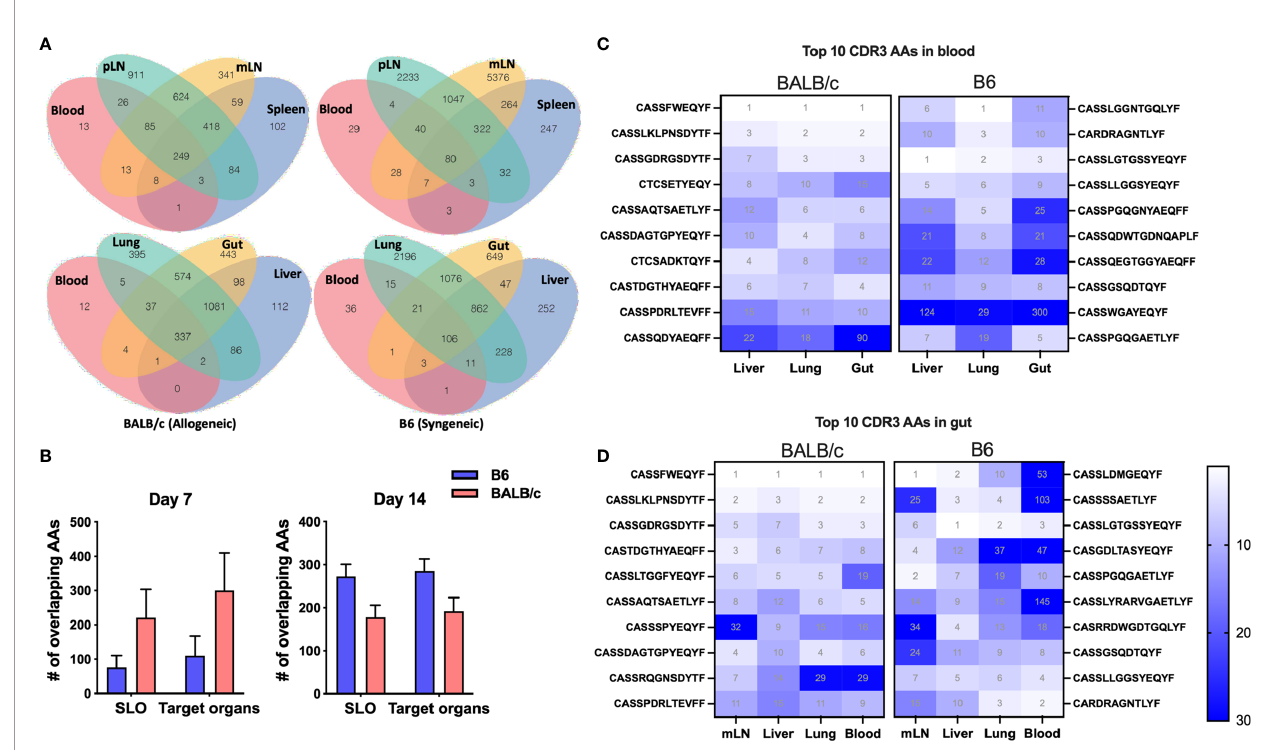
FIGURE 3 | The donor T-cell clone sharing between recipient peripheral blood and GVHD target organs after BMT. Venn diagram shows the overlap between blood and secondary lymphoid organs (SLO) and GVHD target organs for the same CDR3 AAs in a representative B6 recipient (syngeneic) and allogeneic recipient (allogeneic) on day 7 after BMT (A) . The pooled data from replicate mice show the number of overlapped CDR3 AAs between blood and SLO or GVHD target organs on day 7 and day 14 after BMT (B) . Heatmap shows clone ranks of the blood-derived top 10 CDR3 AAs (from top to bottom: top 1 st to 10 th ) in liver, lungs, and gut in a representative recipient on day 7 after BMT (C) . Heatmap shows clone ranks of the gut-derived top 10 CDR3 AAs in liver, lungs, and blood in a representative recipient on day 7 after BMT (D)